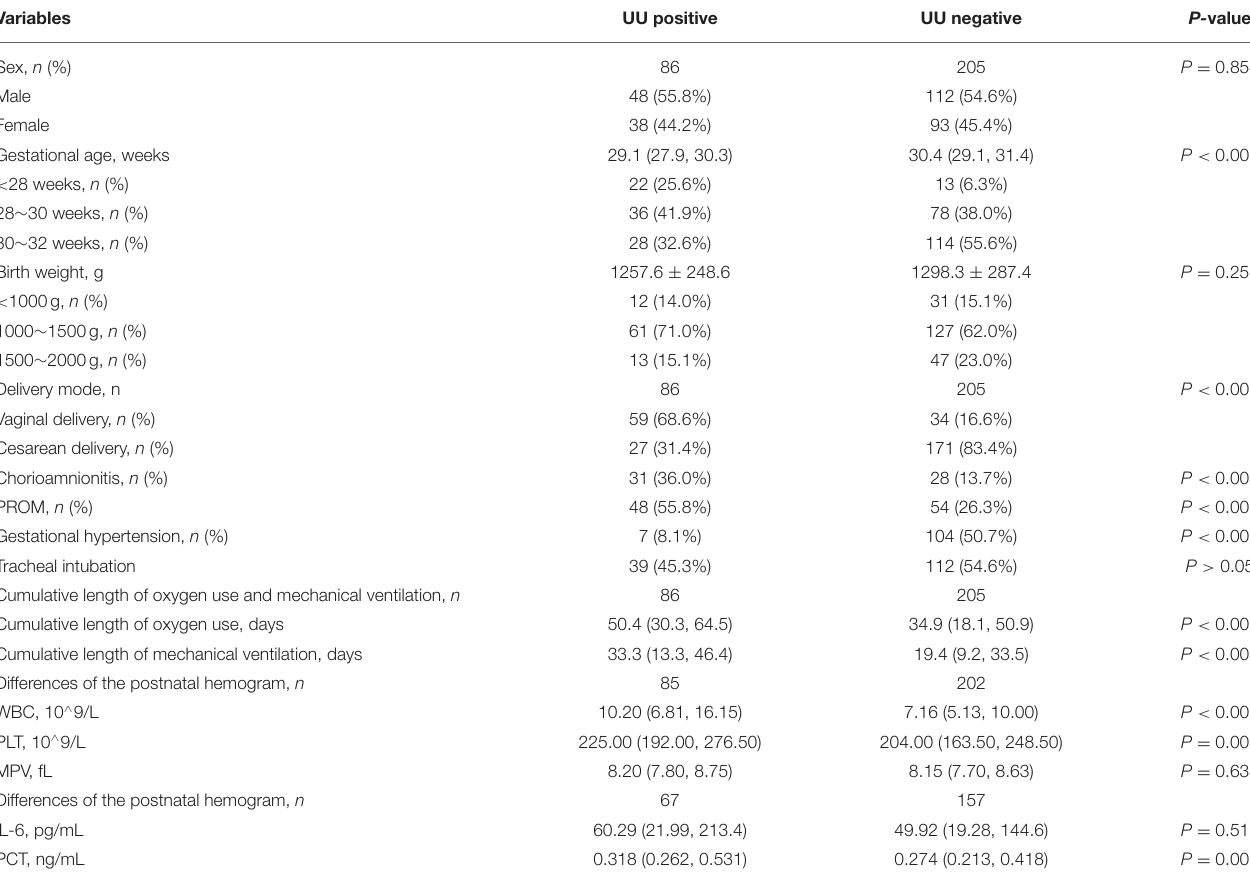
TABLE 1 | The demographic characteristics of UU infected group and non-infected group.